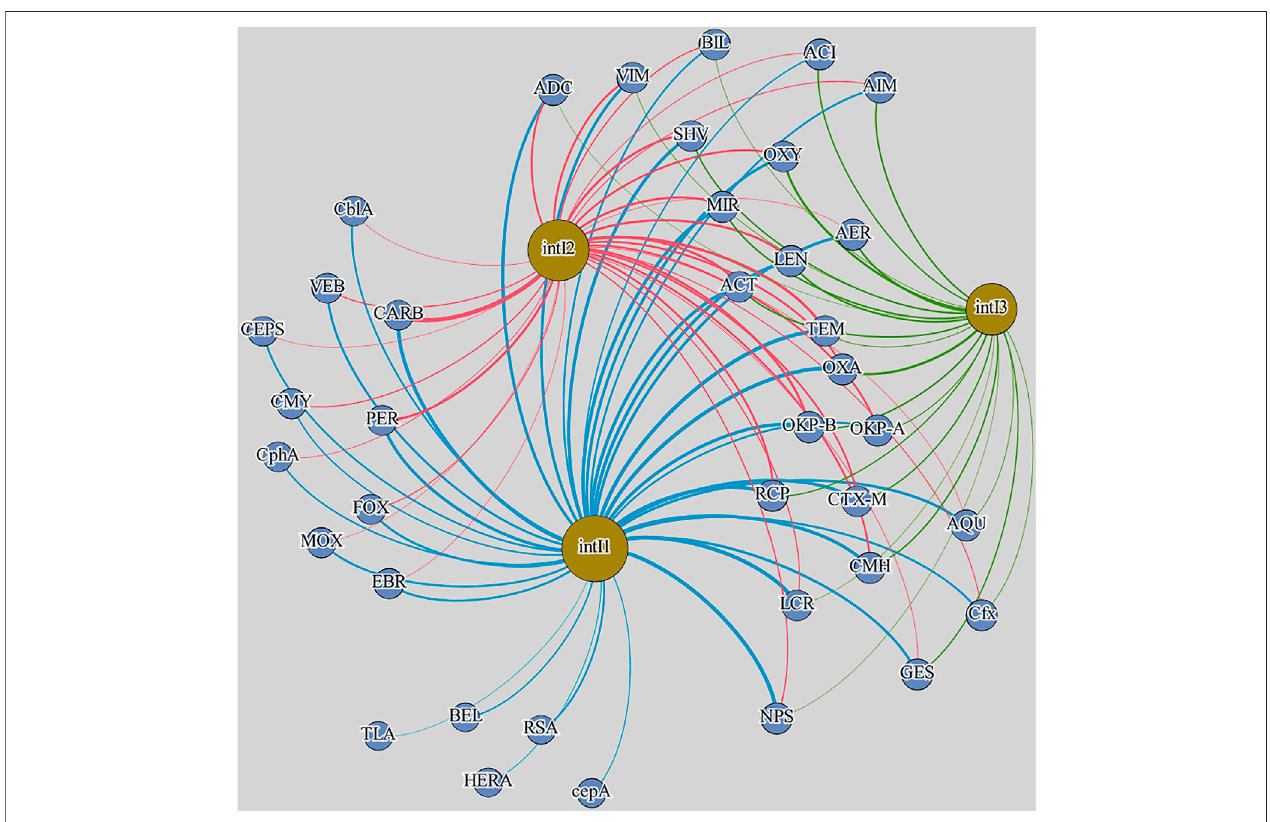
FIGURE 2 | Network analysis of integrase and beta-lactamase genes in samples from WM-WWTP. All correlations in the diagram are statistically signi fi cant ( p < 0.01). Edges: blue — intI1:beta-lactamase gene correlations, yellow — intI2:beta-lactamase gene correlations, pink — intI3:beta-lactamase gene correlations; Nodes: yellow — integron integrase genes, blue — beta-lactamase genes. WM-WWTP stands for the wastewater treatment plant from the Warmia and Mazury